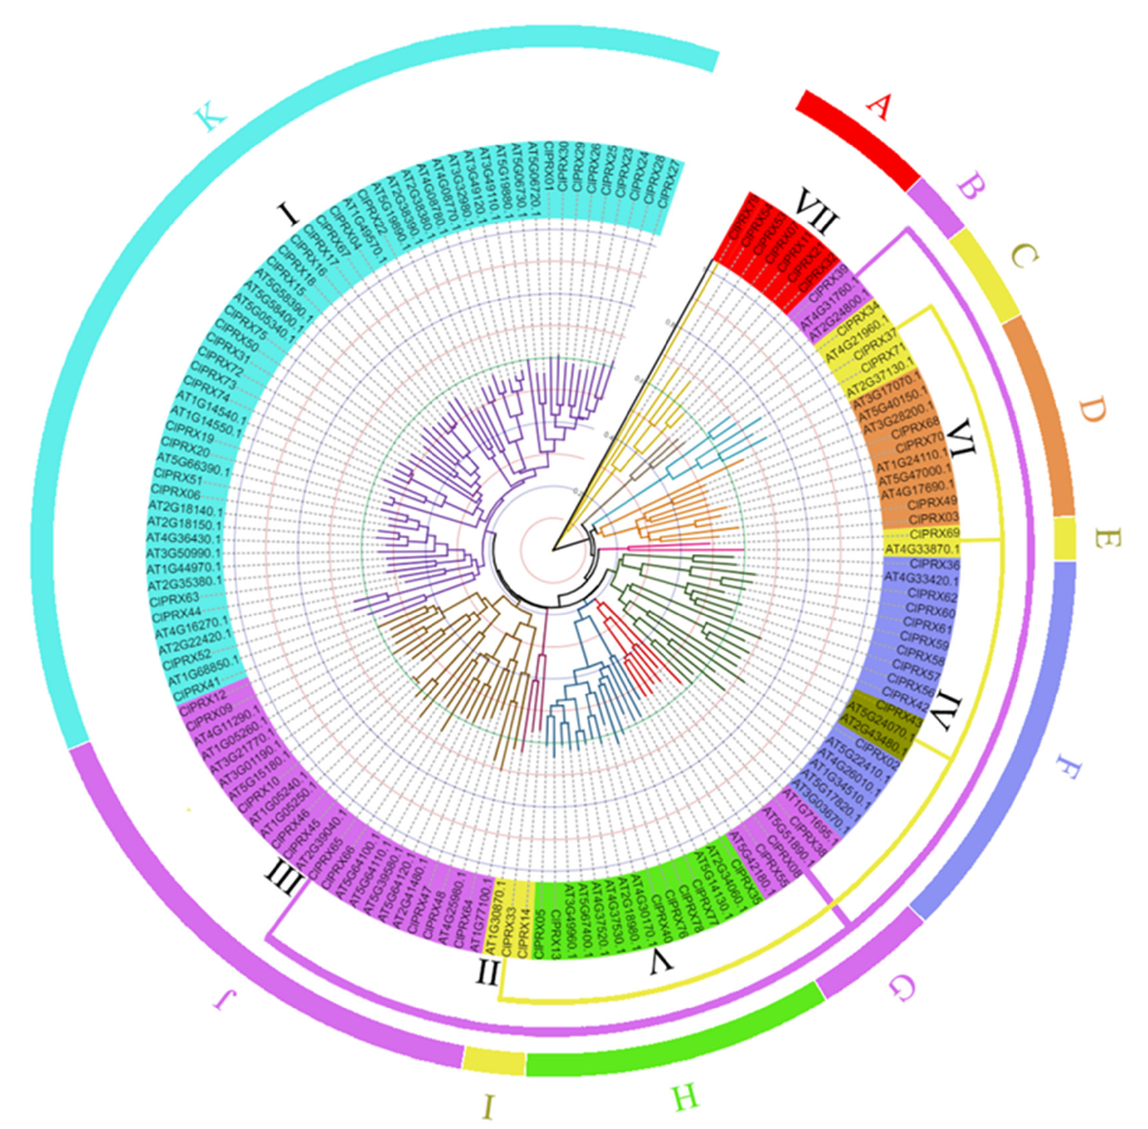
Figure 5. Phylogenetic tree analysis of PRXs in watermelon and Arabidopsis.